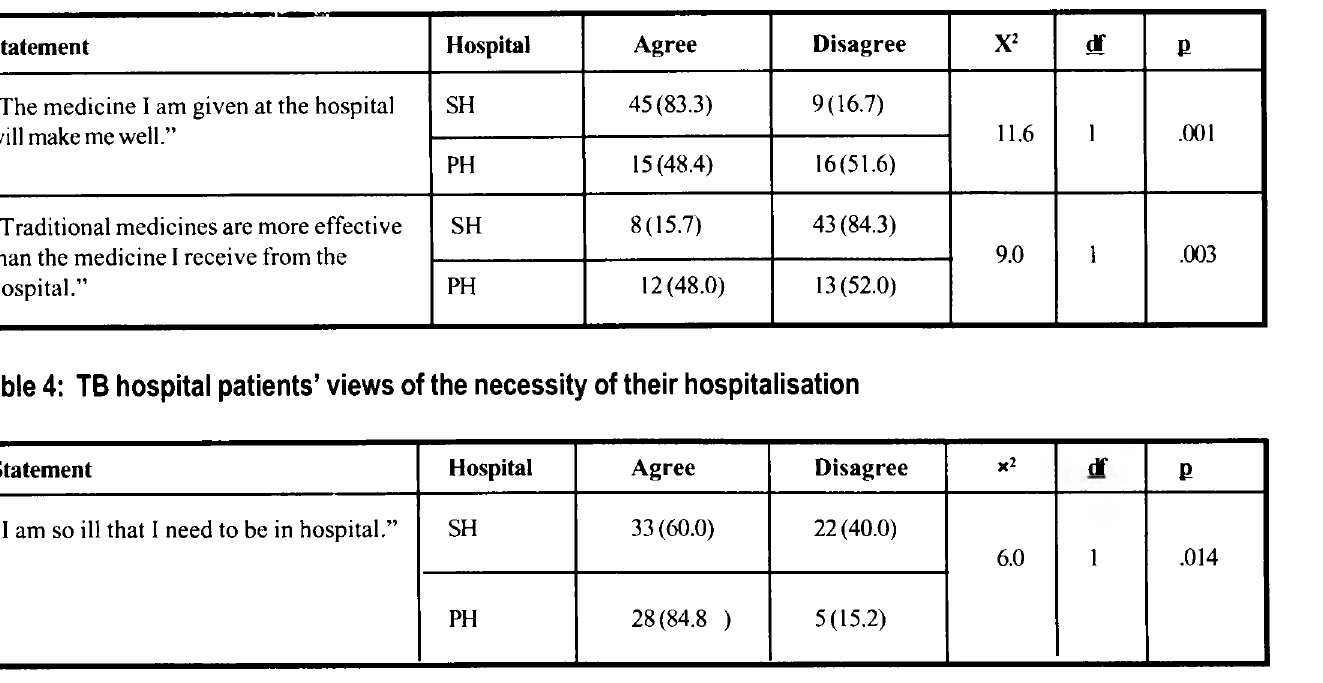
Table 3: TB hospital patients’ health beliefs